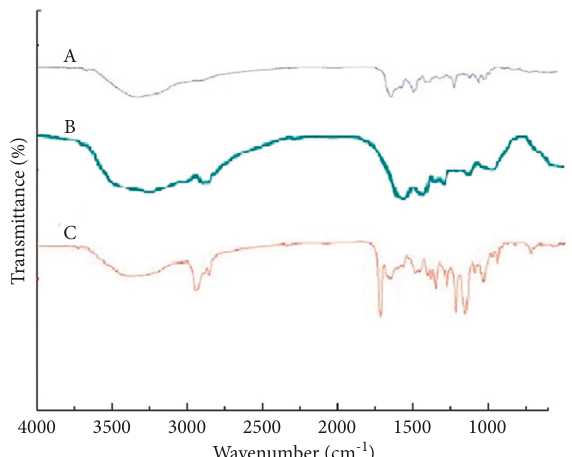
Figure 2: FTIR spectra of designed nanostructures. (a) Vanco- mycin, (b) soy protein nanoparticle (SPNs), and (c) vancomycin- loaded soy protein nanoparticle (vancomycin-SPNs). Character- istic changes in intensity and displacement of the index peaks in the vancomycin-SPNs compared to the free drug and the drug-free SPNs.